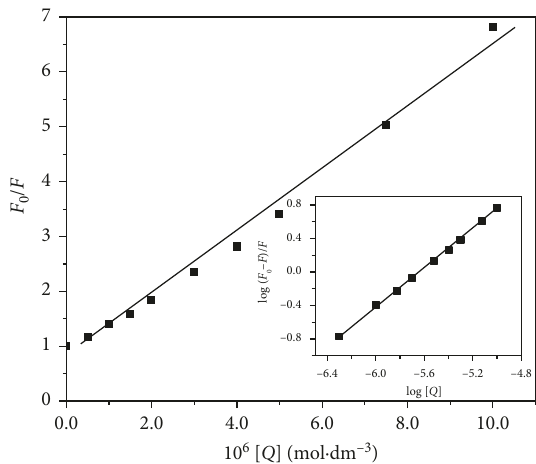
Figure 3: Fluorescence emission spectra of HSA (5 µ M) in the presence of various concentrations of [Ag(I)(Hnor) 2 ]ClO 4 . Curves 1 to 10 correspond to compound concentrations of 0, 0.5, 1, 1.5, 2, 3, 4, 5, 7.5, and 10 µ M, respectively, when excited at 295nm.